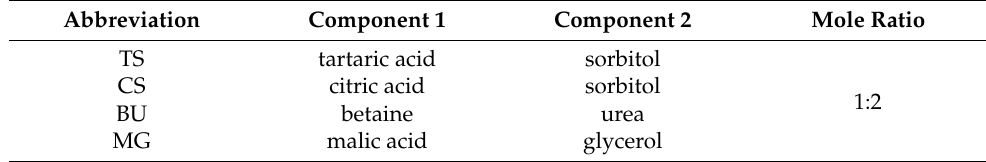
Table 1. Natural deep eutectic solvents used for extraction.